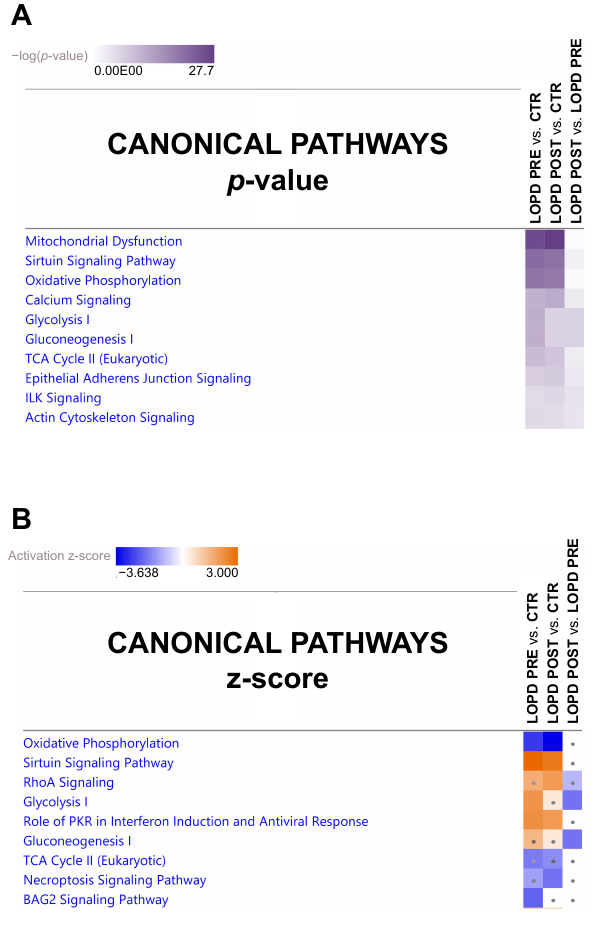
Figure 3. Canonical pathway heatmap displaying the most significant results ( p -value in panel ( A ) and z-scores in panel ( B )) across datasets in LOPD PRE vs. CTR, LOPD POST vs. CTR. and LOPD POST vs. LOPD PRE. The orange and blue colored rectangles indicate predicted pathway activation or predicted inhibition, respectively, via the z-score statistic (z-score ≥ 2, ≤ − 2). Dots are non-significant values for